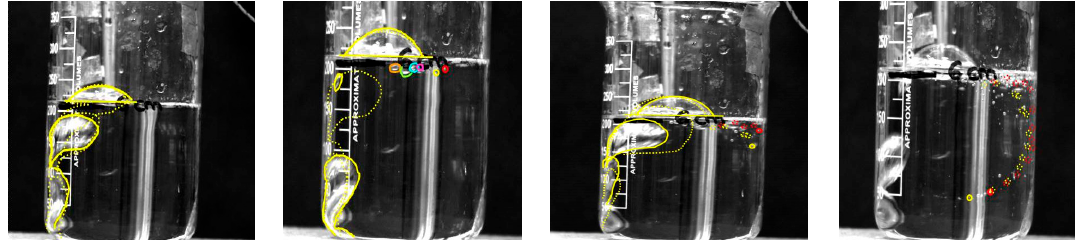
Figure 6. Pictures of the initial stages of bubbling when the small bubbles created at the free surface are captured by the liquid and entrained in its movement. Bubbles dragged by the liquid flow are highlighted by yellow and red circles.